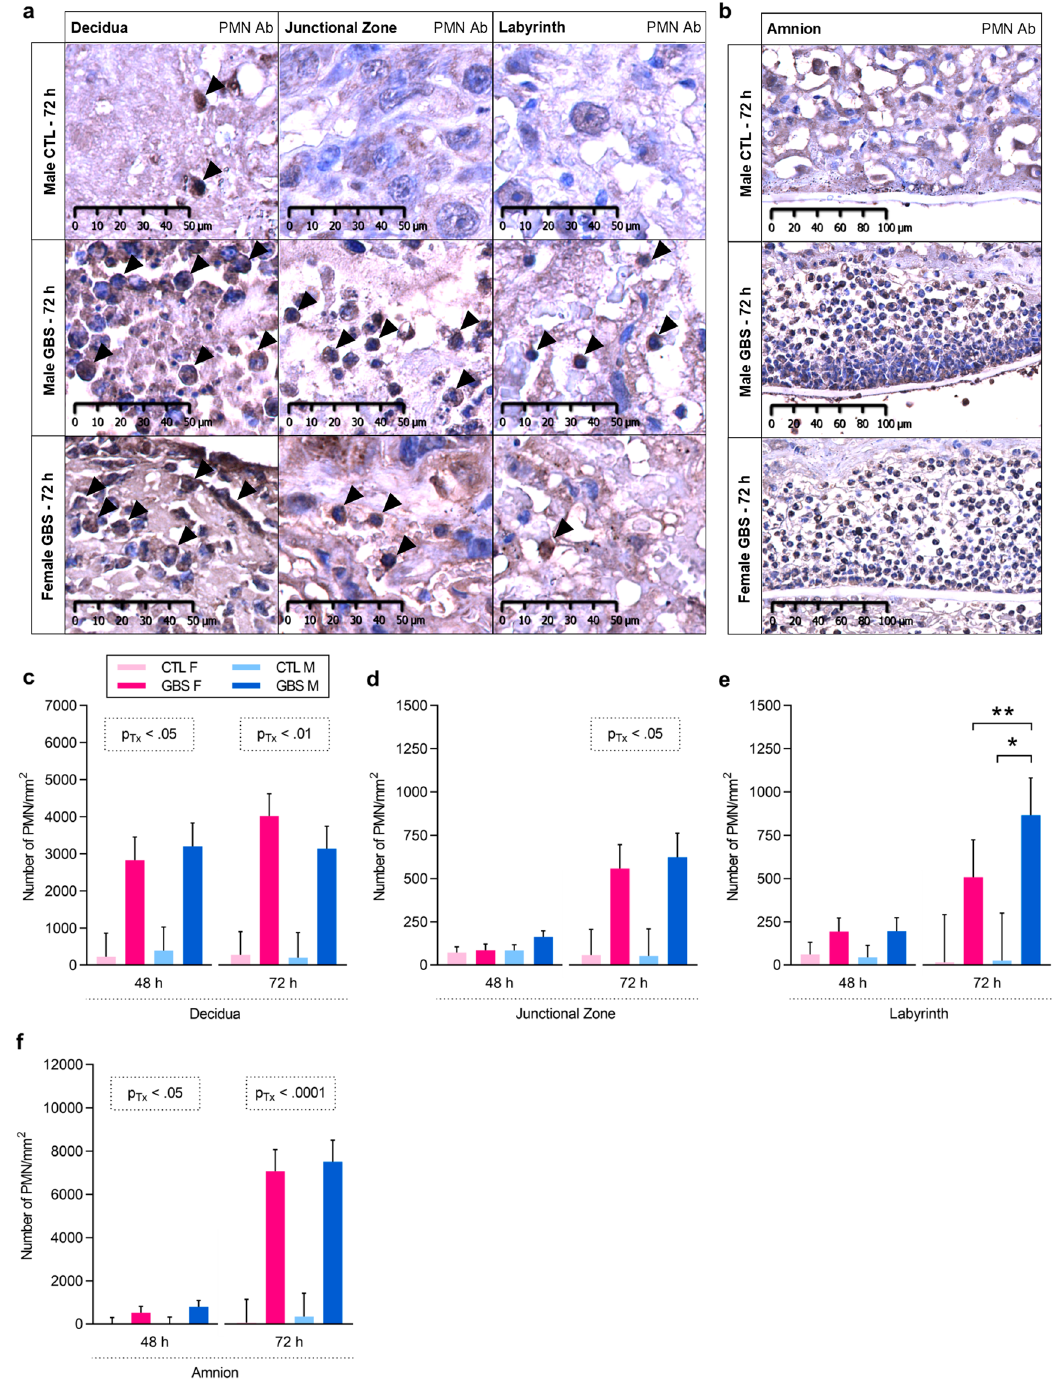
Figure 2. Prenatal GBS infection induces sexually dichotomous polymorphonuclear cells (PMNs) infiltration in placentas. ( a , b ) Representative images of PMN infiltrates in the decidua, junctional zone, labyrinth ( a ) and amnion ( b ) in placentas at 72 h post-injection. ( c – f ) Mean density of PMNs detected by immunohistochemistry in the decidua ( c ), junctional zone ( d ), labyrinth ( e ) and amnion ( f ) at 48 and 72 h post-injection. Analyses were done by linear mixed model and significant results are shown in the dashed box. Sidak’s multiple comparisons were used when the interaction between sex and treatment was significant. * P < 0.05, ** P < 0.01. Bars represent mean ± SEM. Number (n) of placentas: n = 3 [48 h] and n = 6 [72 h] per sex in the GBS group, and n = 5 [48 h] and n = 5 [72 h] per sex in the CTL group. One male and one female placentas were used per litter. Abbreviations: Ab, Antibody; CTL, Control; F, Female; GBS, Group B Streptococcus ; h, hour; M, Male; Tx,